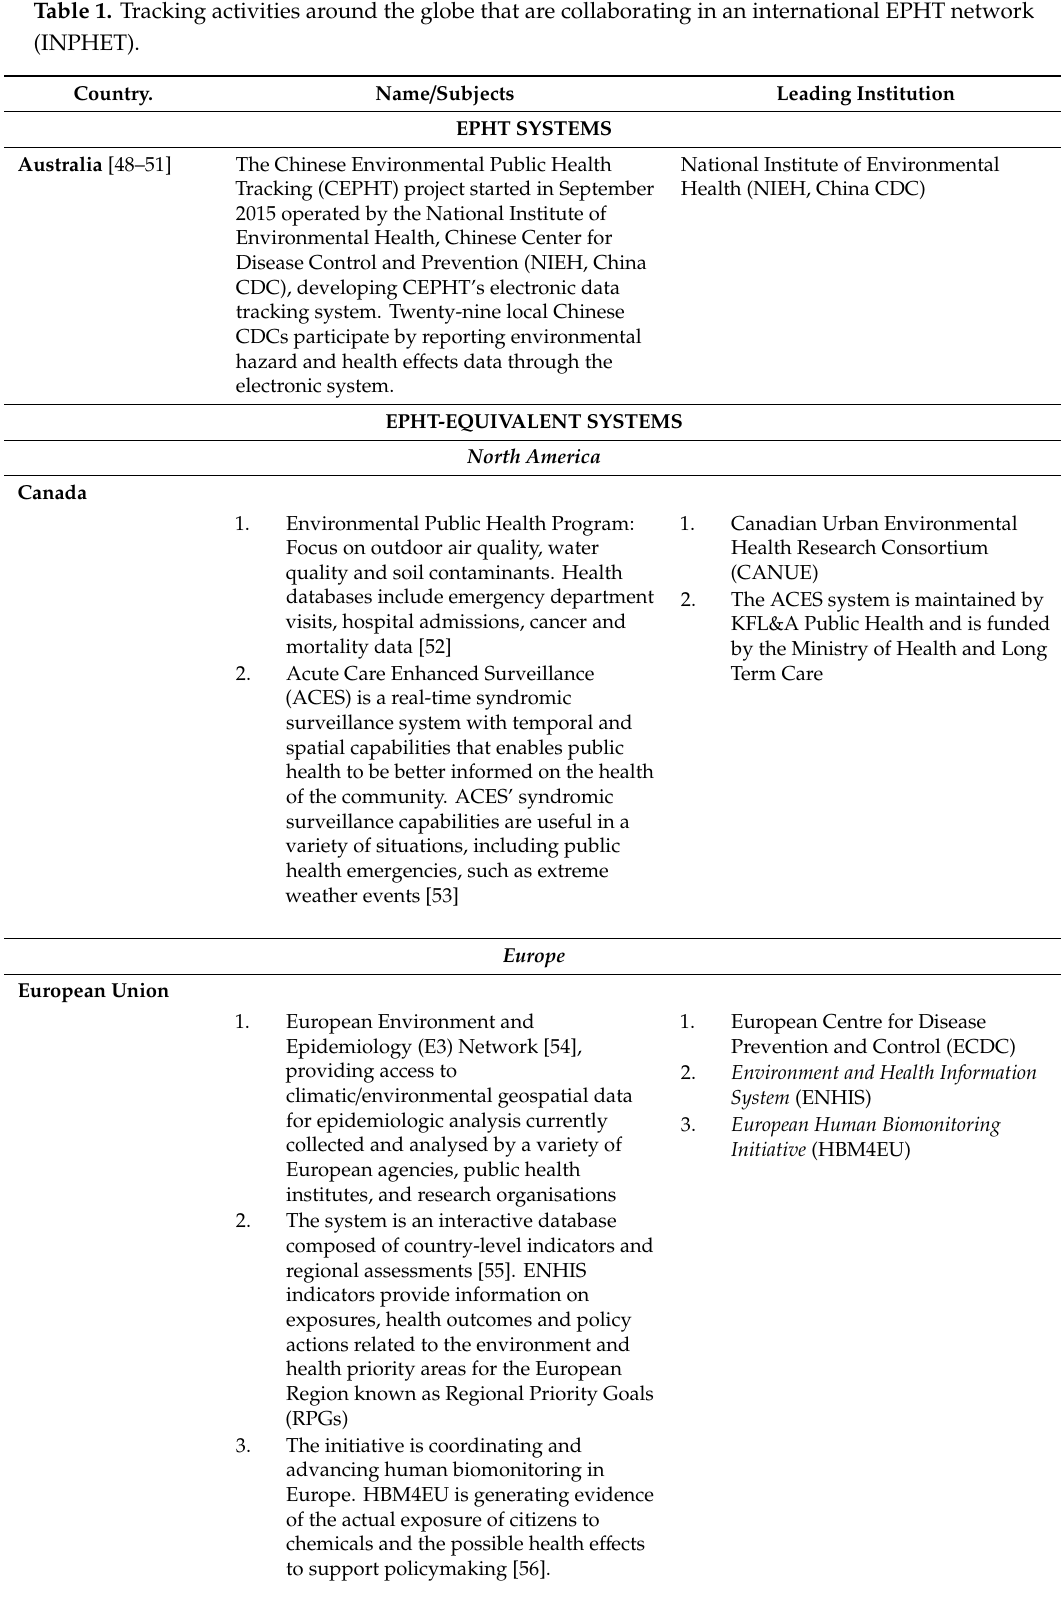
Table 1. Tracking activities around the globe that are collaborating in an international EPHT network (INPHET).